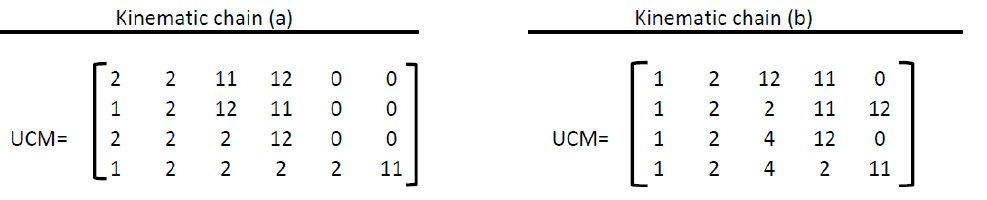
Figure 13. 15-links kinematic chains with simple joints. ( a ) kinematic chain: a. ( b ) kinematic chain: b The link assortment array (LAA) and joint assortment array (JAA) for the KCs shown in Figure 13a,b are illustrated in Table 8. Furthermore, Figure 13 illustrates all the joint labels and their corresponding joint degrees. Table 8. Link Assortment Array and Joint Assortment Array for kinematic chains in Figure 13. Kinematic Chain (a)